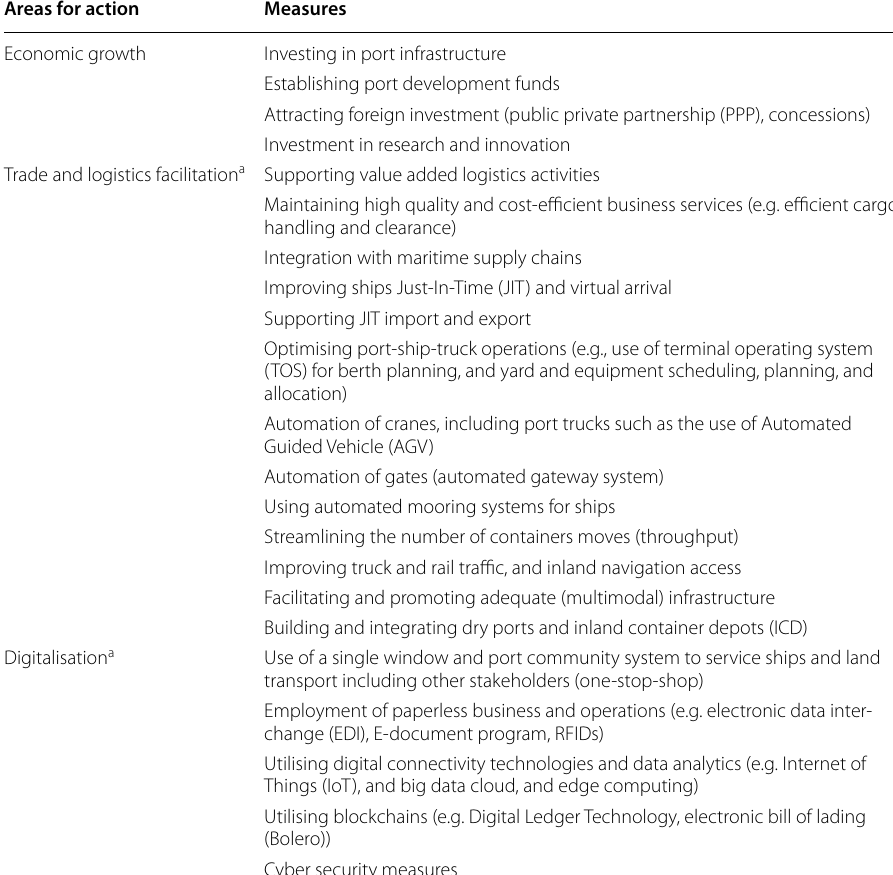
a Measures within these actions improve air quality as well as climate change mitigation due to reduction of energy consumption